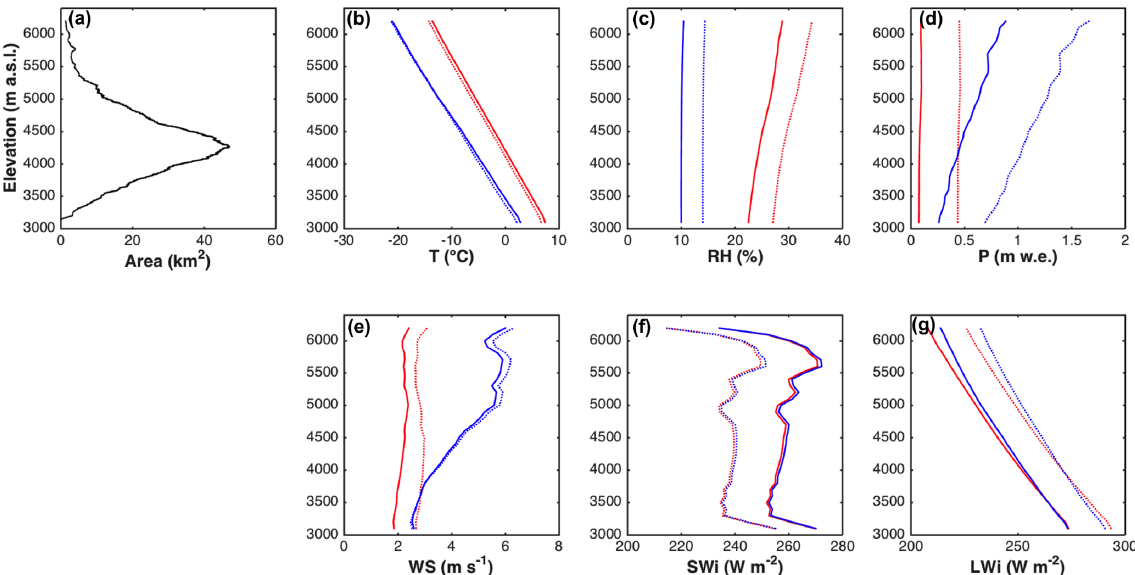
Figure 4. (a) Area–elevation distribution of the La Laguna catchment. (b–g) MicroMet outputs at the catchment scale forced by the AWS (red) and the WRF (blue) for 2014 (lines) and 2015 (dashed lines).